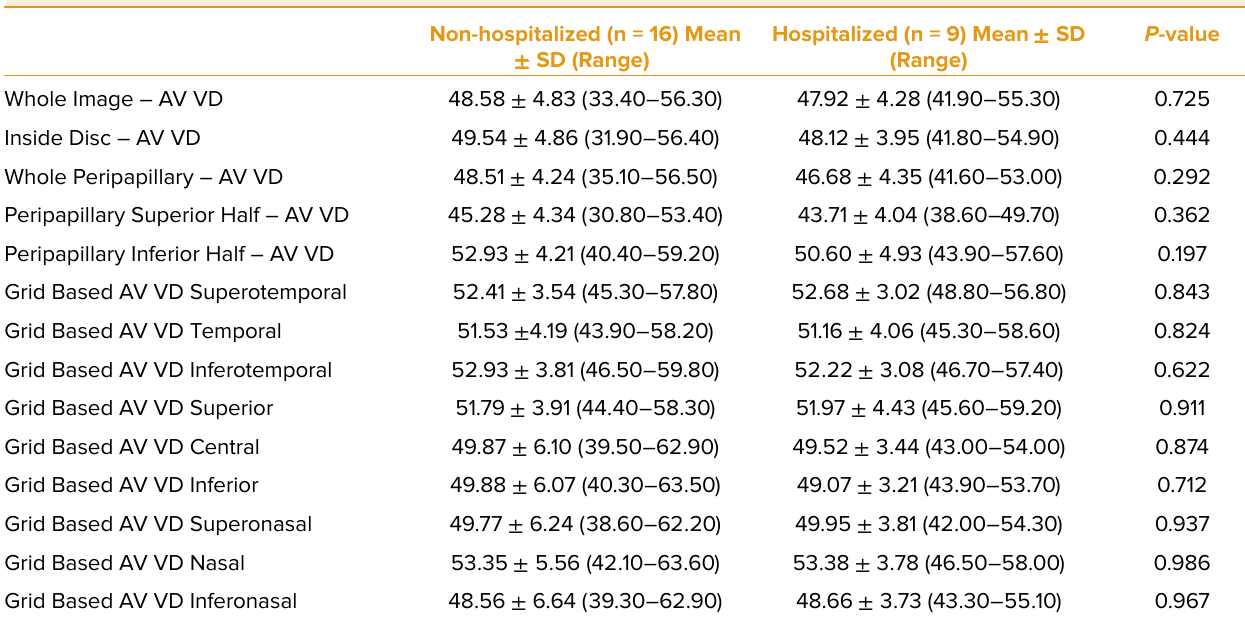
Table 5. Comparison of all vessels (AV), including both small and large vessels, vessel density (VD) of hospitalized versus non- hospitalized/outpatients treated COVID-19 patients Non-hospitalized (n = 16) Mean